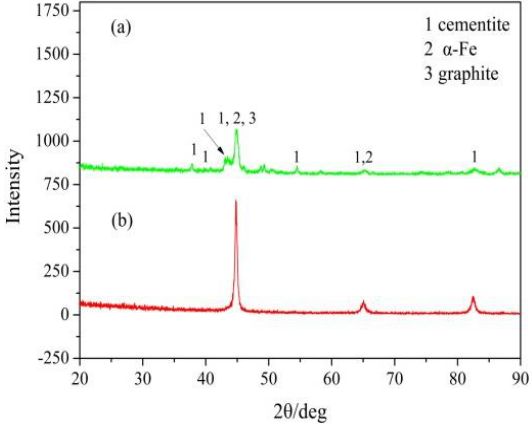
Figure 7. XRD diffraction patterns of (a) the the top of the gradient remelted layer (M1) and (b) the position where the hardness was two-thirds of the top of the remelting layer (M2).